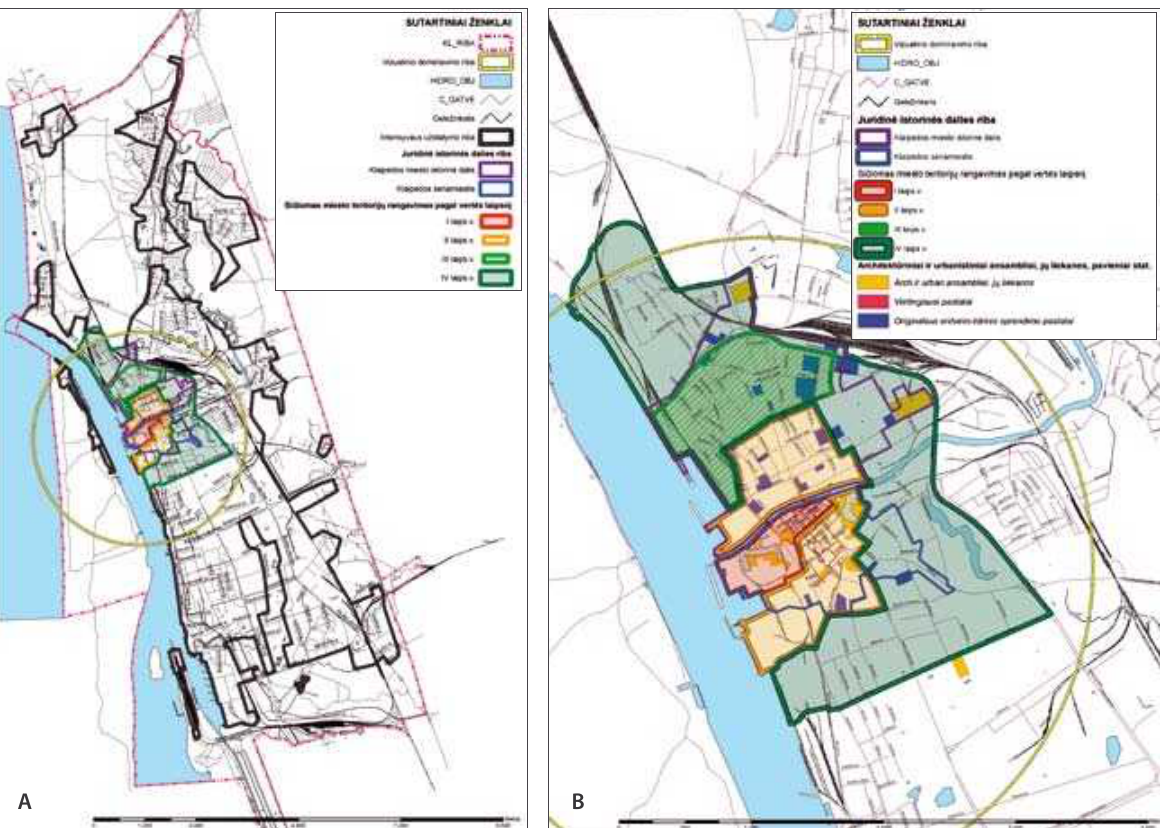
Fig. 2. Hierarchy of value for territories of klaipėda city: A – on a city scale; b – on a central-part